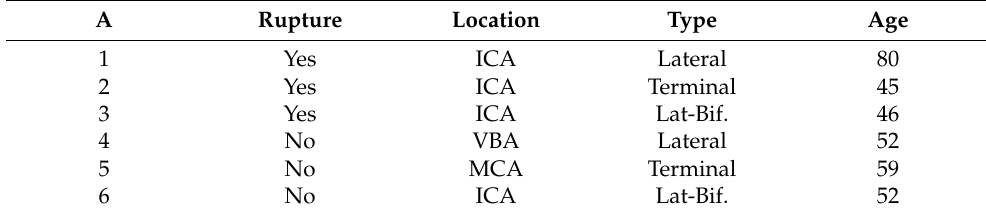
Figure 2. The six cerebral aneurysms models under study. From A-1 to A-3 ( left ) are ruptured and from A-4 to A-6 ( right ) are unruptured. Table 1. Rupture status, location, type, and patient age of each aneurysm model.